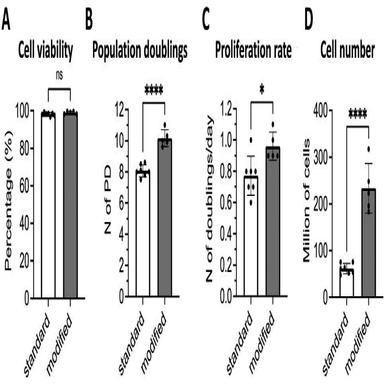
Cell viability (A), PDs (B) and proliferation rate (C) and cell number (D) of NC expanded in medium containing autologous serum (standard process) or hPL (modified process). Values are mean § standard deviation of parameter generated from cells cultured in the standard (n = 7 donors) or modified (n = 5 donors) process. P < 0.05, P < 0.005, P < 0.0005, P < 0.00005. ns = no significant difference.